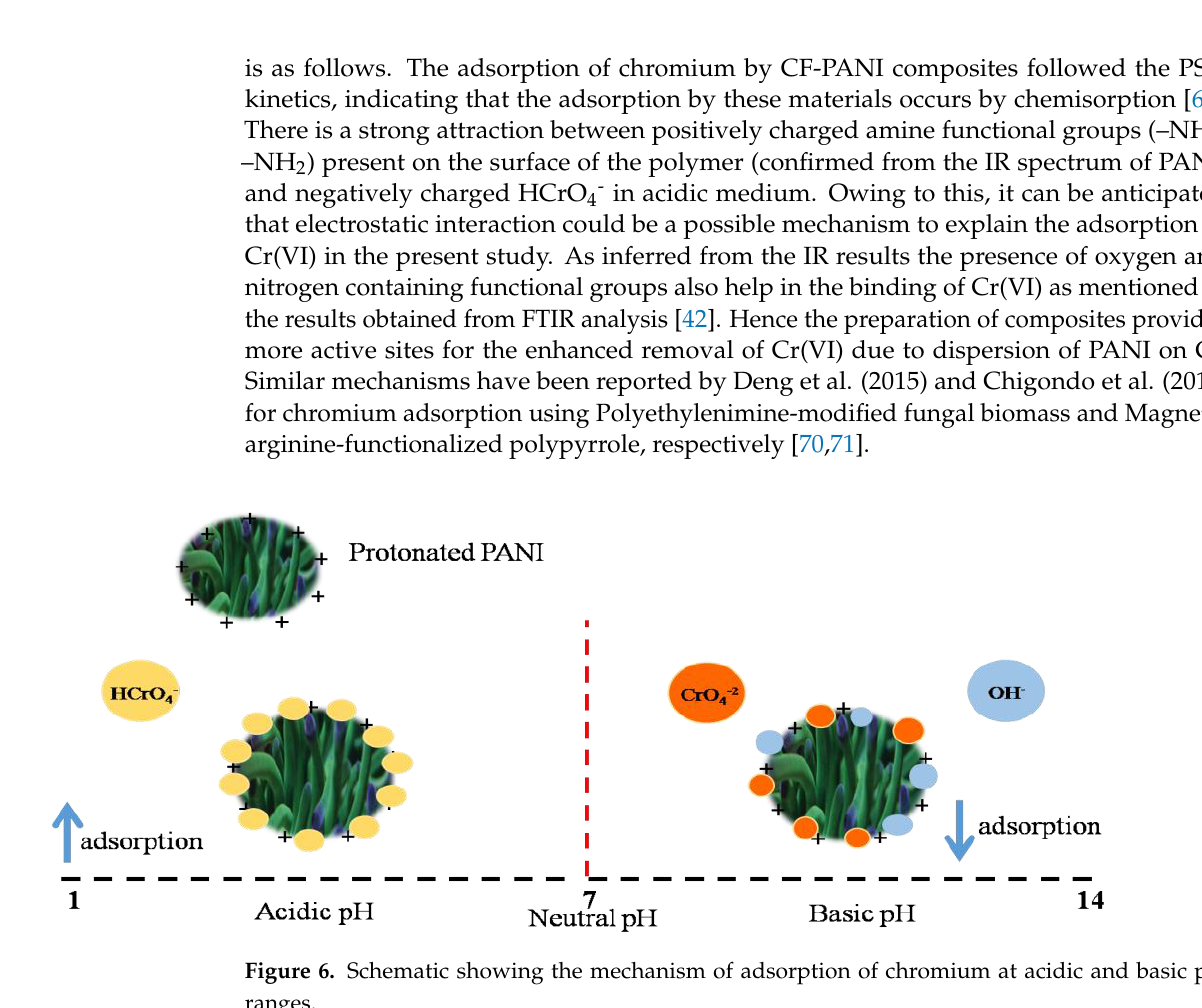
Table 5. Summary of research papers on the removal of chromium using PANI and bio-waste based adsorbents.